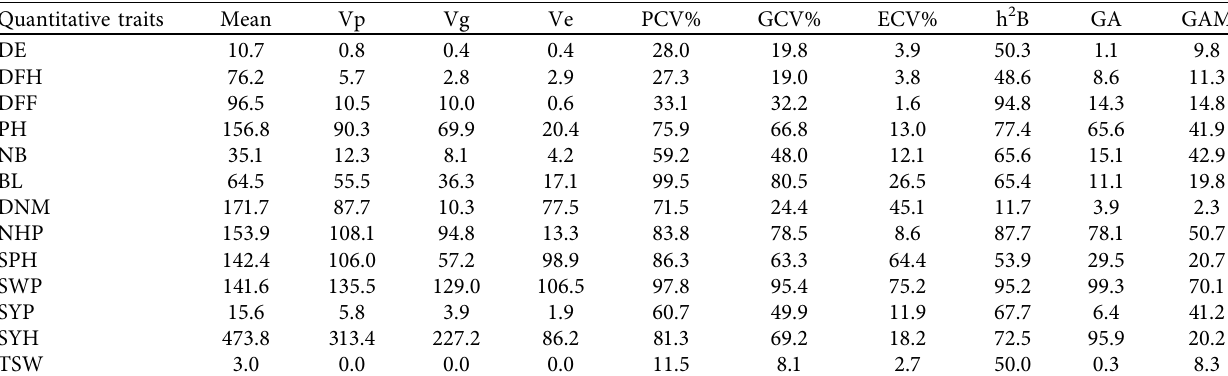
Significant at p < 0 . 05. Table 3: Estimates of mean, genotypic coefficient of variations (GCVs), phenotypic coefficient of variations (PCVs), heritability, and genetic advance as a percentage of the mean (GA%) for 13 quantitative traits. Quantitative traits